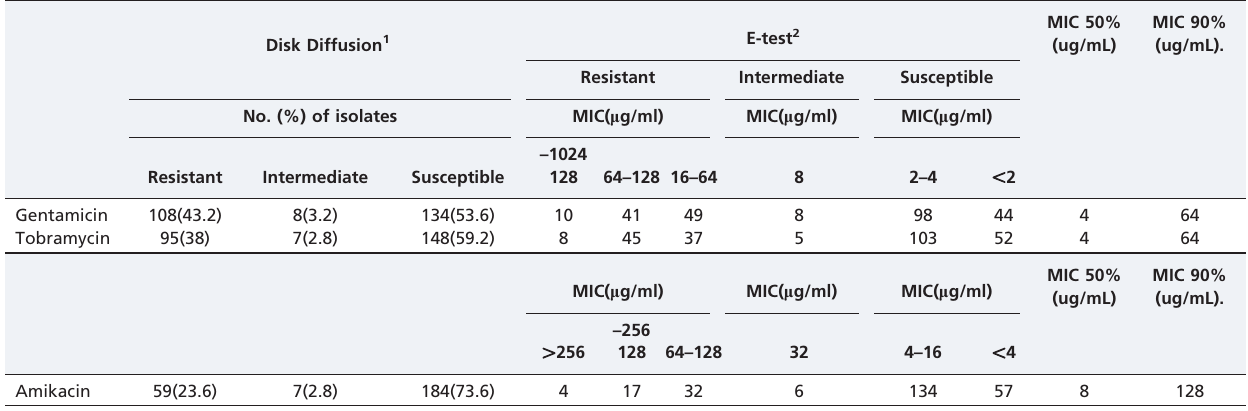
Table 1 - Aminoglycoside susceptibility profiles according to the disk diffusion method and MIC results (E-test) for 250 P. aeruginosa isolates (according to CLSI guidelines).